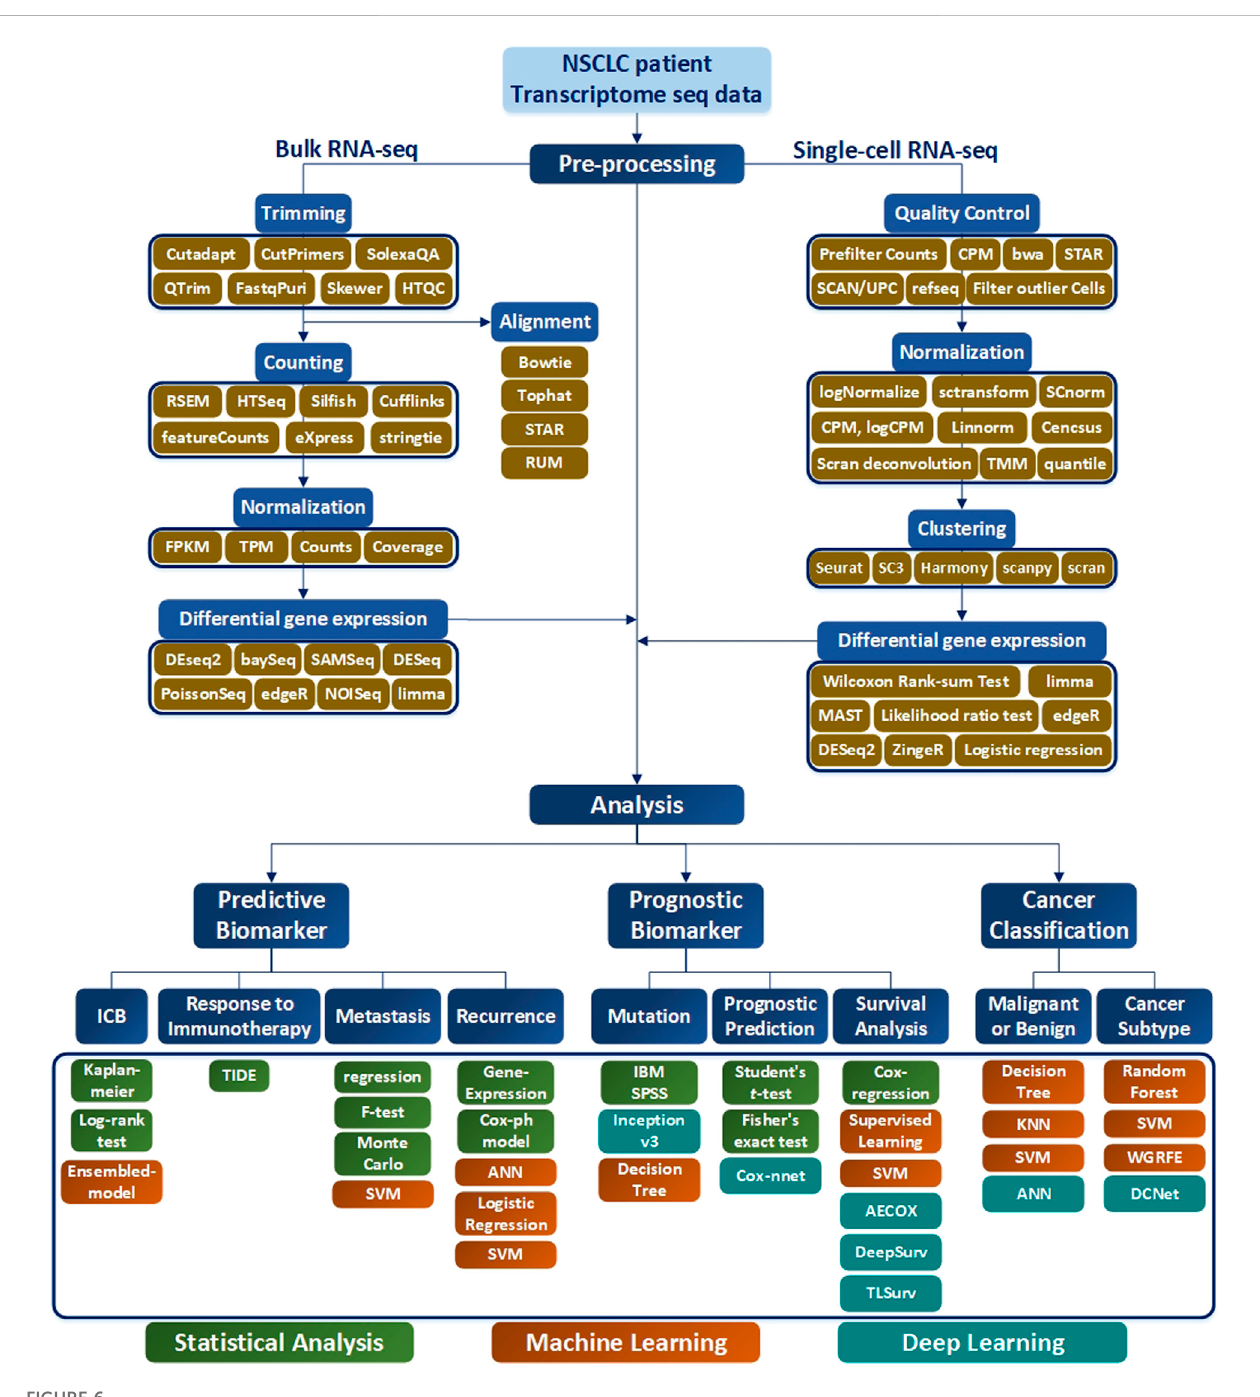
FIGURE 6 RNA-seq work fl ow of how to preprocess data and conduct analysis. The preprocessing section is divided into bulk RNA-seq and single-cell RNA-seq, where each require quality control. In addition, differential gene expressions are derived to obtain data for analysis. In the Analysis section, the target is classi fi ed into Predictive Biomarker, Prognostic Biomarker, and Cancer Classi fi cation, and analysis methods are sub-classi fi ed according to each purpose. In addition, the necessary tools according to the data type are indicated in green for Statistical Analysis, orange for the Machine Learning techniques, and blue for the me`thods using Deep